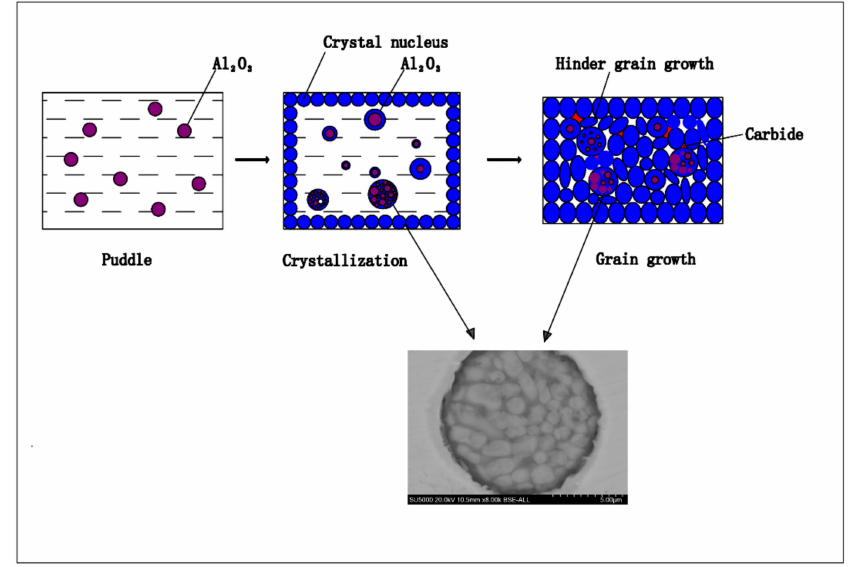
Figure 10. Modified sample crystallization process diagram (5% wt. Al 2 O 3